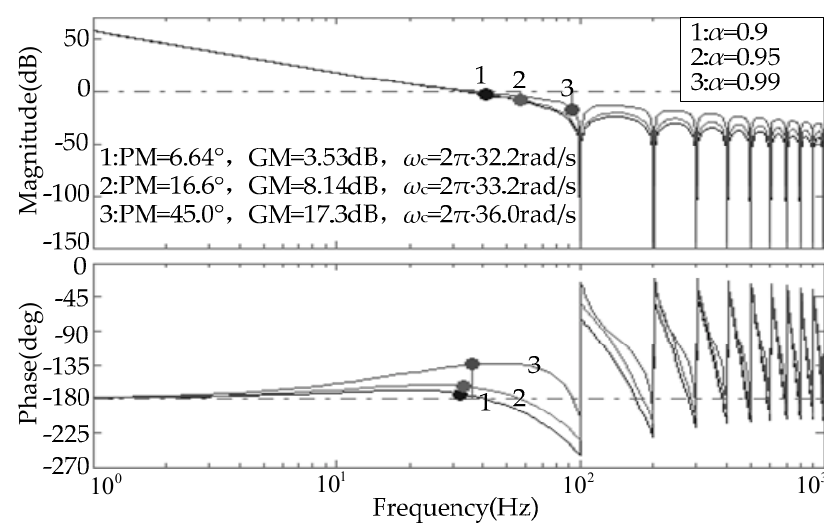
Figure 5. Bode plot of the open-loop transfer function of MCF-PLL, with N = 100.